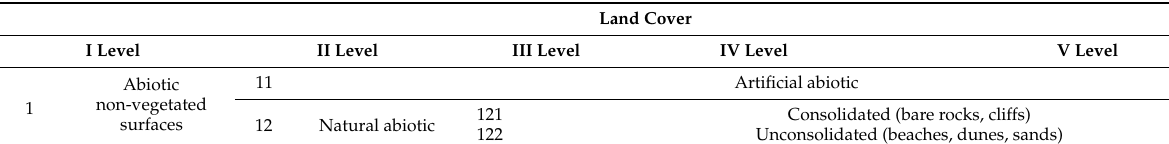
Table 3. Land cover map classification system.